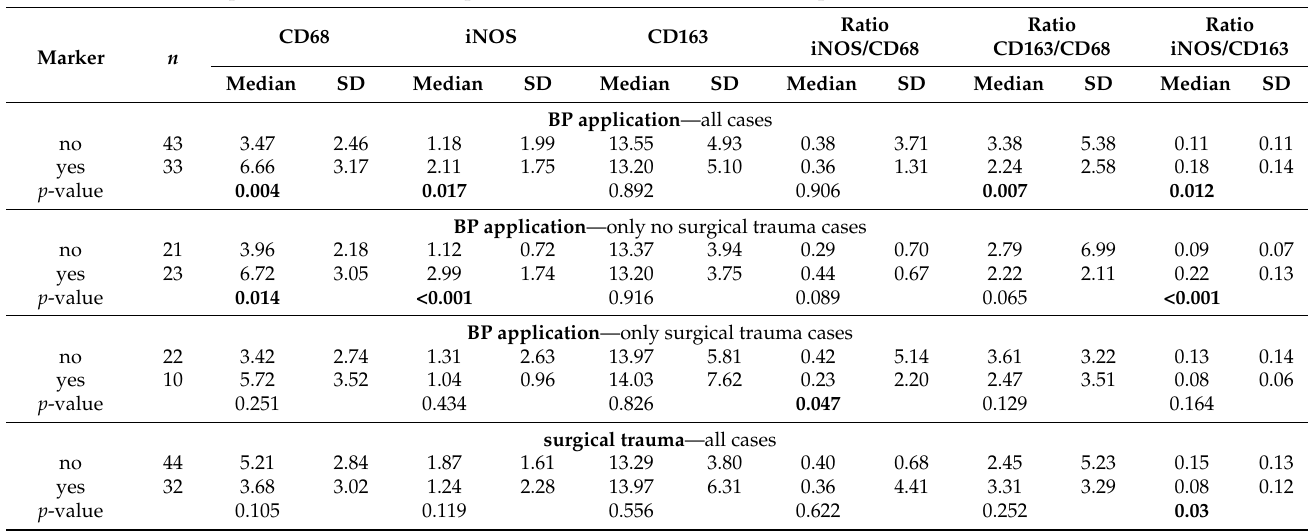
Table 1. CD68. iNOS und CD163 expressions (pos. cells/all cells in %) and iNOS and CD163 to CD68 ratios. p -values were calculated by the